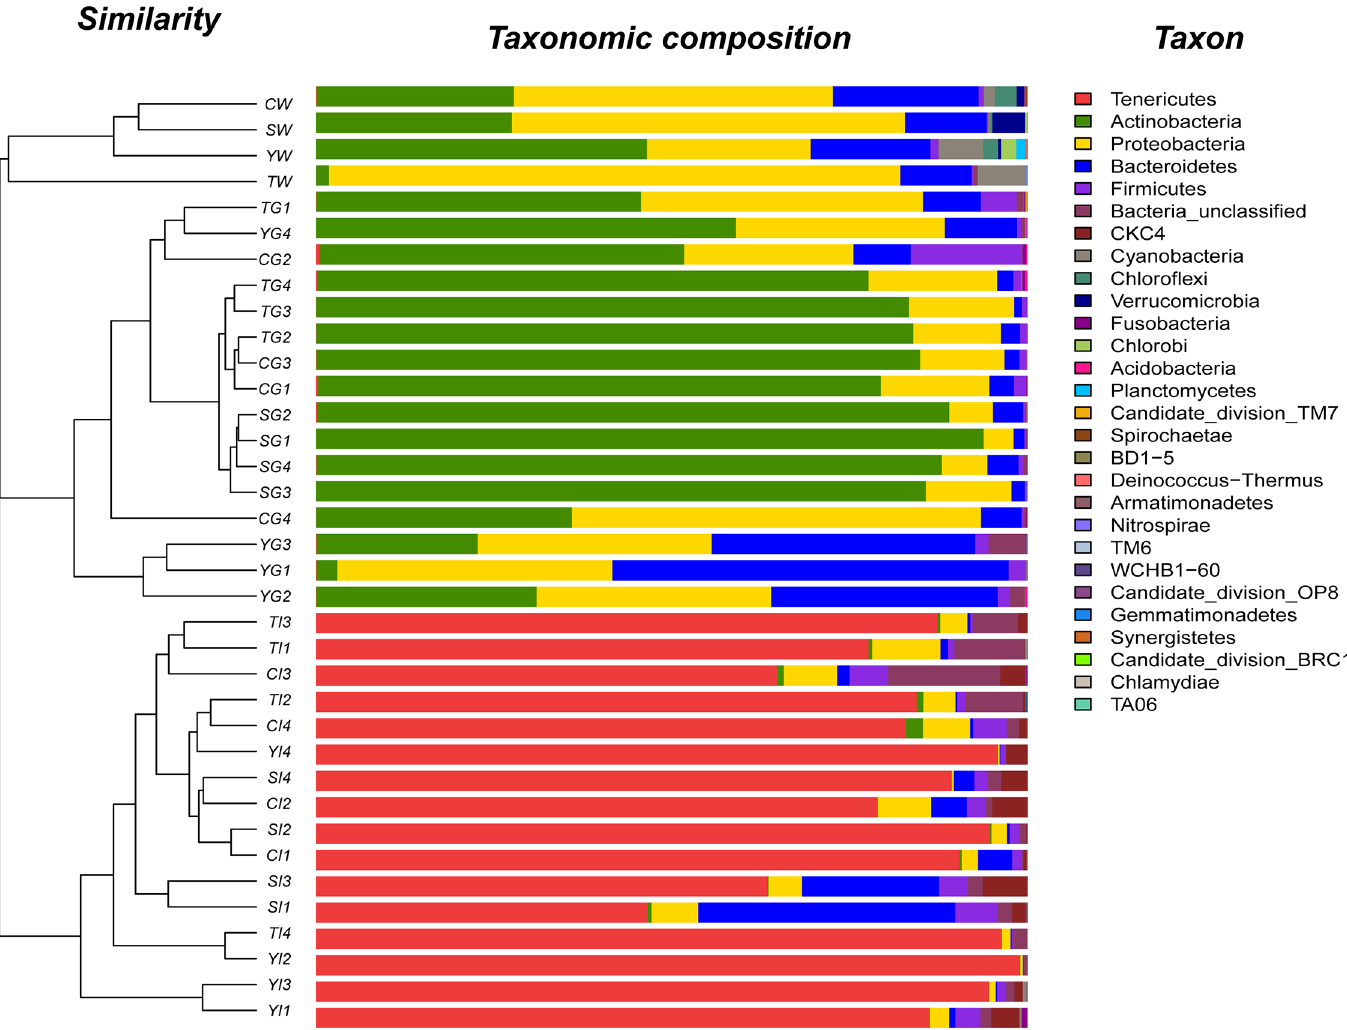
Fig 1. Frequency distribution of bacterial phyla in water, gills and guts. Similarity among samples was calculated using the Bray-Curtis